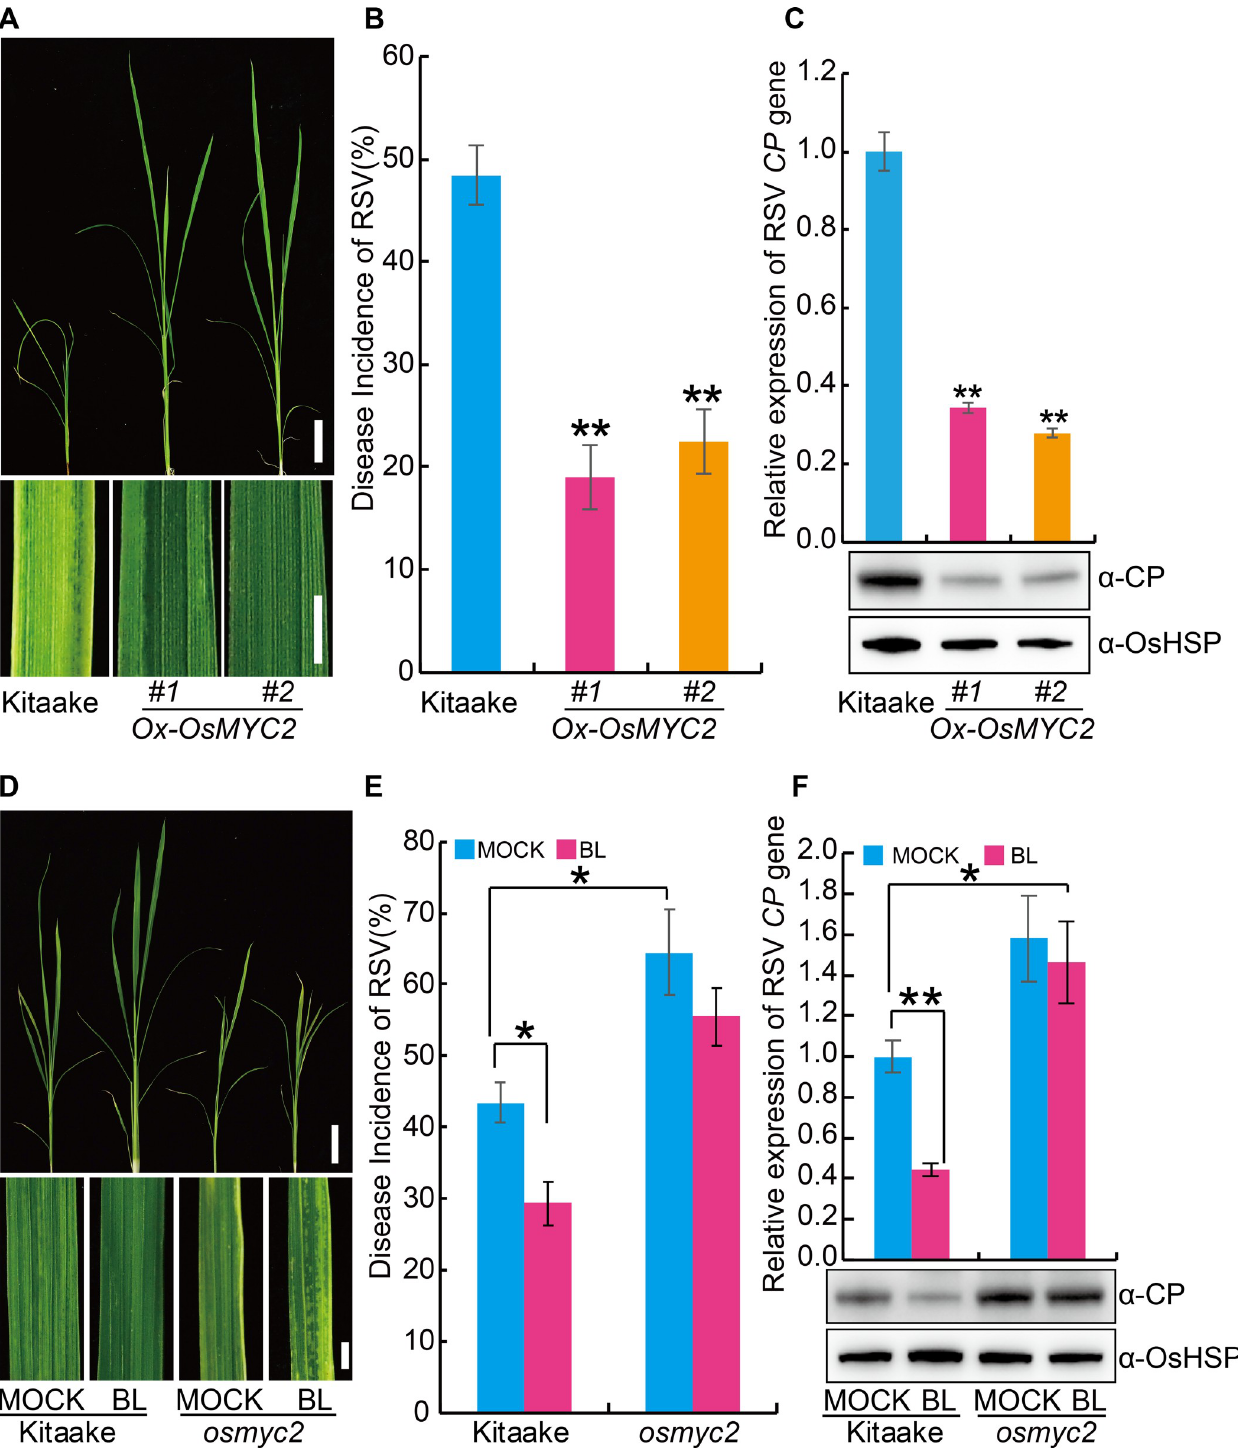
Fig 5. OsMYC2 plays a positive role in the resistance against RSV in rice. (A) Representative images of Kitaake and OsMYC2 overexpressing ( Ox- OsMYC2 ) plants infested with RSV-carrying SBPH. Bar = 5 cm (top). Bar = 3 mm (bottom). (B) RSV incidence of Kitaake and Ox-OsMYC2 at 30-day dpi with RSV-carrying SBPH. (C) Detection of RSV CP RNA expression levels (upper panel) by quantitative RT–PCR assay and western blot analysis of the RSV coat protein (lower panel) in the RSV-infected plants of Kitaake and Ox-OsMYC2 , respectively. OsHSP was used as loading control. (D) Representative images of Kitaake and OsMYC2 knockout ( osmyc2 ) plants infested with RSV-carrying SBPH after pretreatment with 1 μ M BL or MOCK (0.1% Triton X-